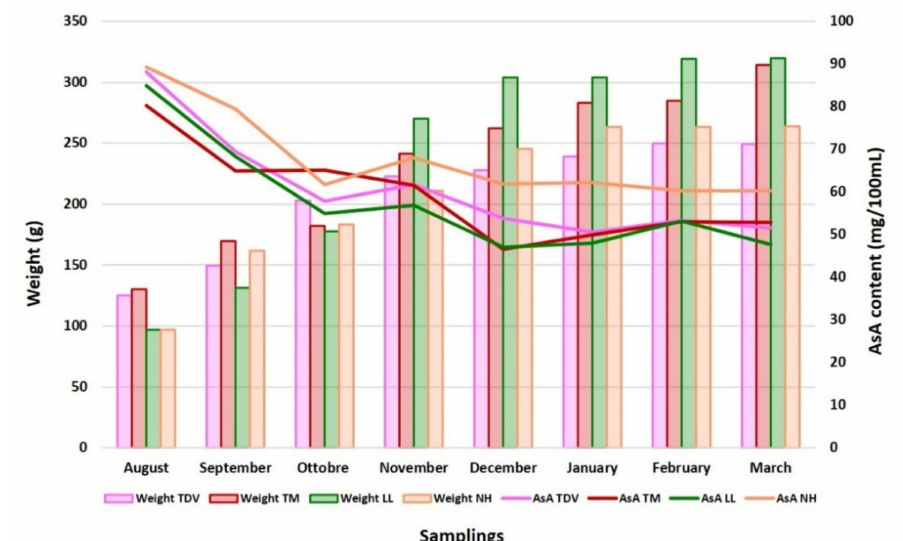
Figure 3. The decrease in the AsA content in relation to the stages of fruit growth and ripening in the juice of the four analysed varieties (Lanelate (LL), Tarocco Meli (TM), Newhall (NH), and Tarocco TDV (TDV)). Bars represent fruit weight and lines represent the AsA